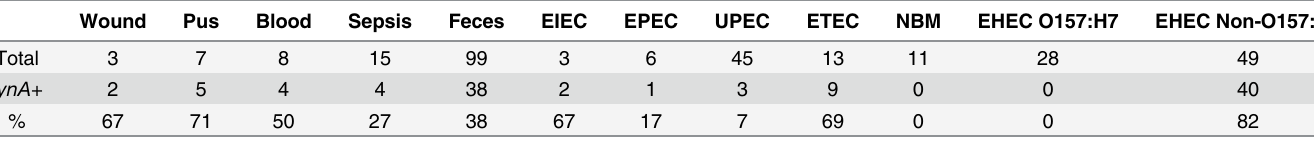
Table 2. Frequency of E . coli in human isolates. a